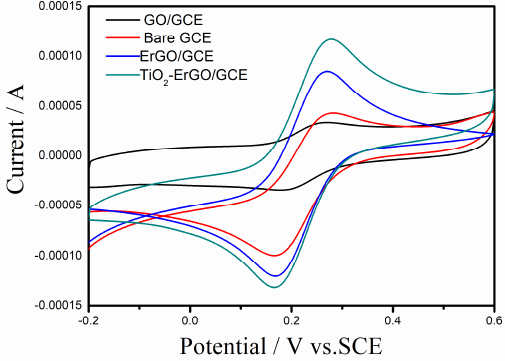
Figure 2. Cyclic voltammograms of bare glassy carbon electrode (GCE), GO–GCE, reduced graphene oxide-modified GCEs (ErGO–GCE), andTiO 2 –ErGO–GCE in 2.5 × 10 −3 mol/L [Fe(CN) 6 ] 3−/4− solution.